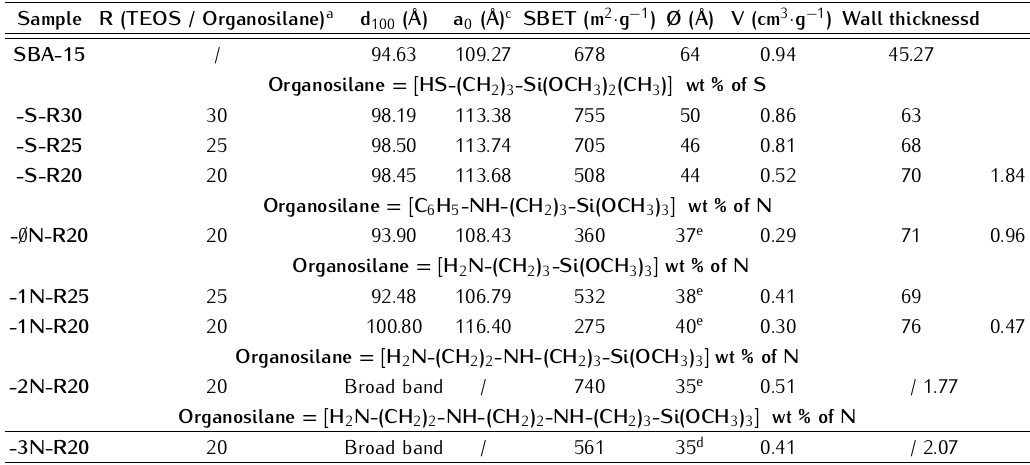
Table 3. Properties of synthesized SBA-15 and functionalized materials after extraction of the surfactant. Sample R (TEOS / Organosilane)